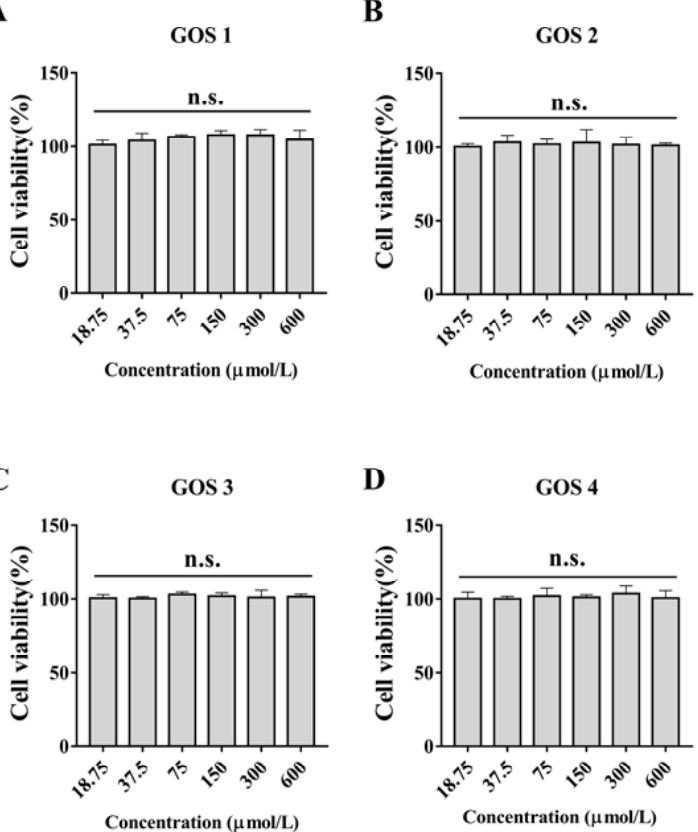
Figure 2. Effects of different concentrations of GOS1-4 on cell viability of RAW264.7 macrophages after treatment for 24 h: ( A ) GOS1, ( B ) GOS2, ( C ) GOS3, and ( D ) GOS4. N.s., not significant ( n = 3).